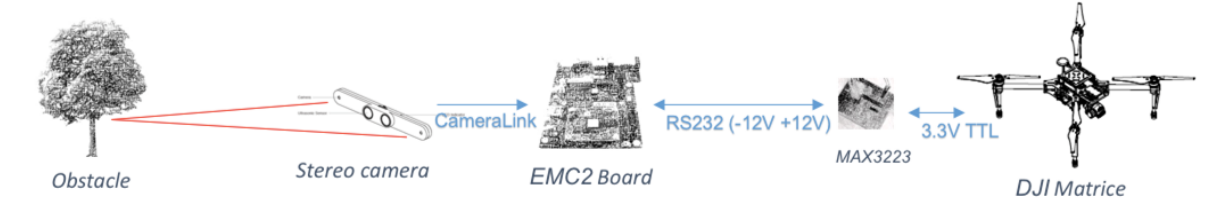
Figure 5. Schematic overview depicting interoperability of our approach with the DJI Matrice 100 UAV system. D right can be efficiently approximated by reusing the previously computed C aggr to compute the WTA disparities: D right (p) = arg min C aggr ((p x + d, p y ) , d ) d